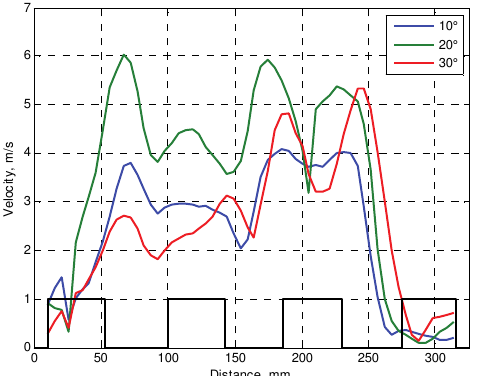
Fig. 15. Air velocity profiles in the manifold outflow plane for different throttle position angles at 2000